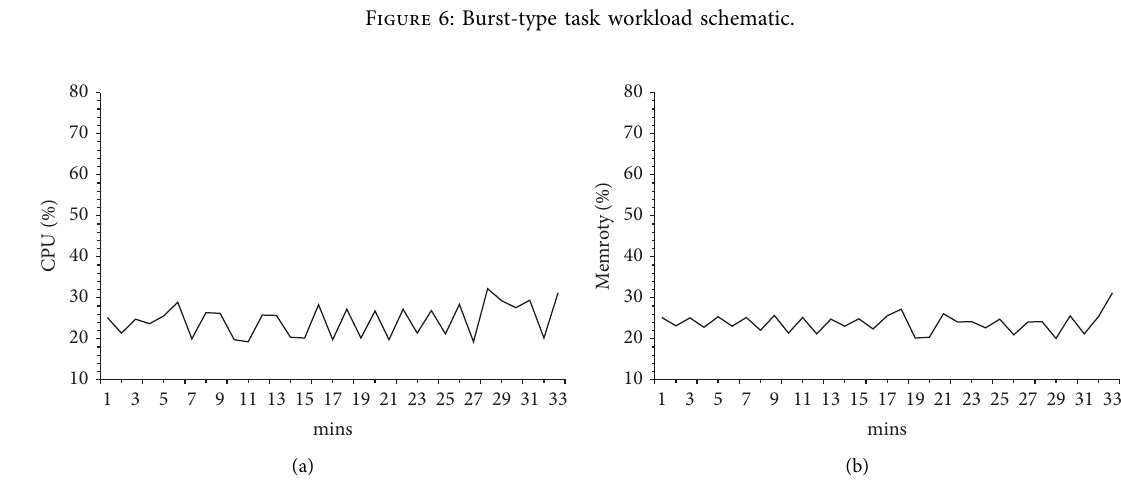
Figure 6: Burst-type task workload schematic.